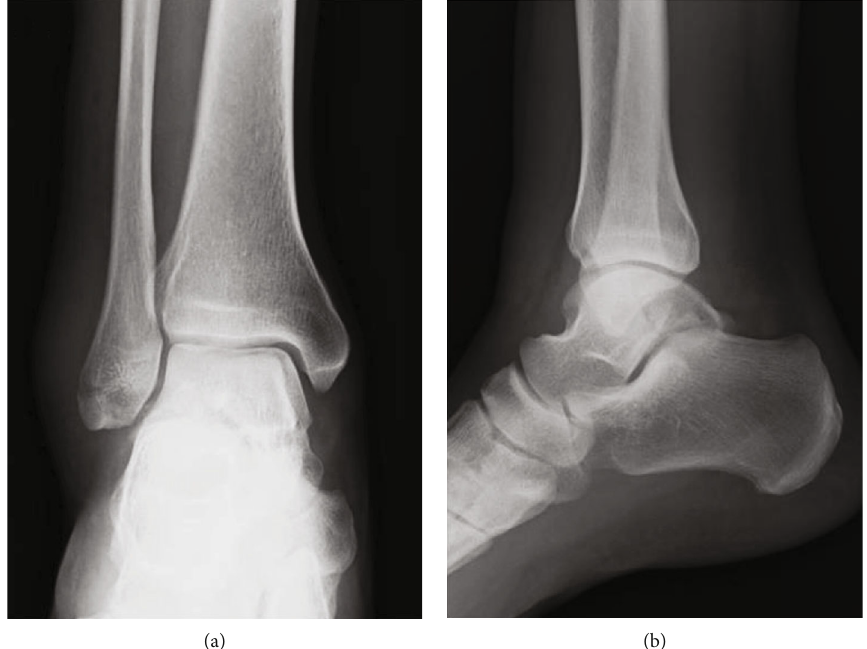
Figure 1: Plain radiographs of the right ankle showed no abnormal fi ndings in (a) anteroposterior and (b) lateral views.